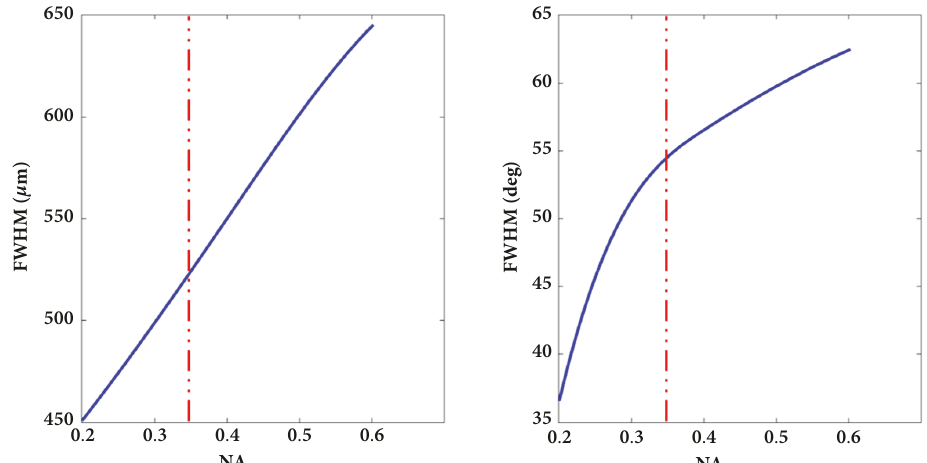
Figure 3: Plots of the effects from a varying NA on the FWHM for the fluorescent of a 250 𝜇 m particle. Left plot shows the behavior of the FWHM vertically while right plot shows the behavior radially. The red lines represent the NA =0.34 which is the NA of the optical fiber in our system.